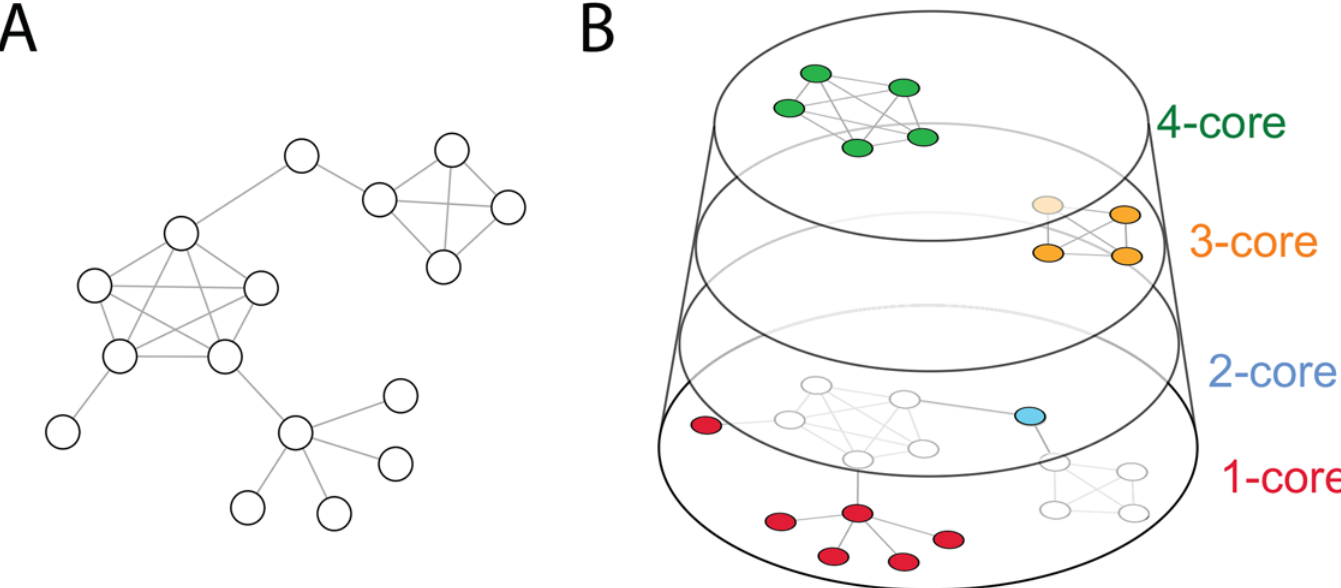
Fig 2. Schematic representation of the k -core decomposition for a random network with N = 16 vertices and E = 24 edges. This technique recursively prunes the network to remove nodes with the lowest degree. The coreness of a vertex is k if it belongs to the k -core but not to the ( k +1)-core.